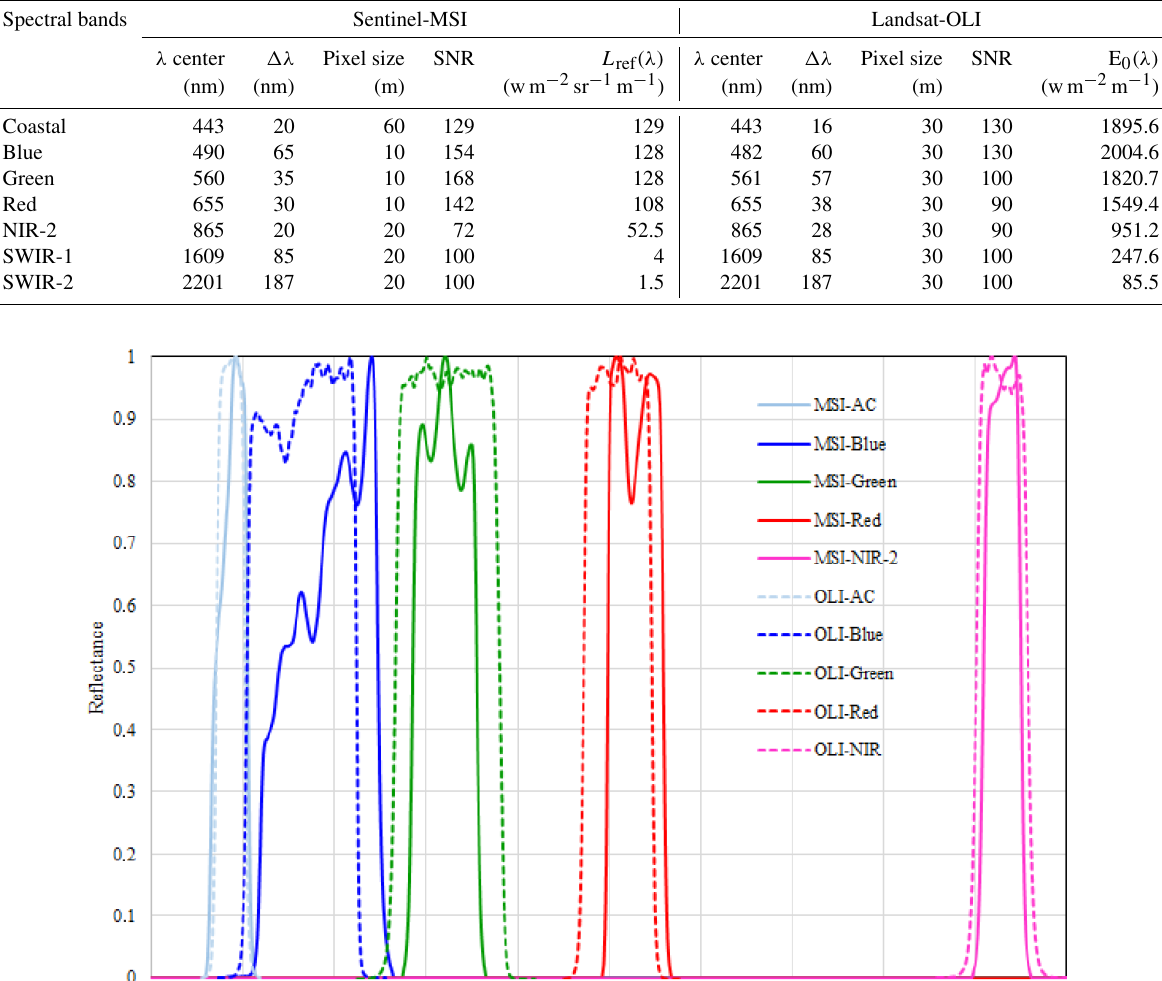
Table 1. The Sentinel-MSI and Landsat-OLI effective bandwidths and characteristics ( λ indicates wavelength, SNR is signal to noise ratio, L ref (λ) indicates reference radiance, E 0 (λ) indicates extra-atmospheric irradiance).